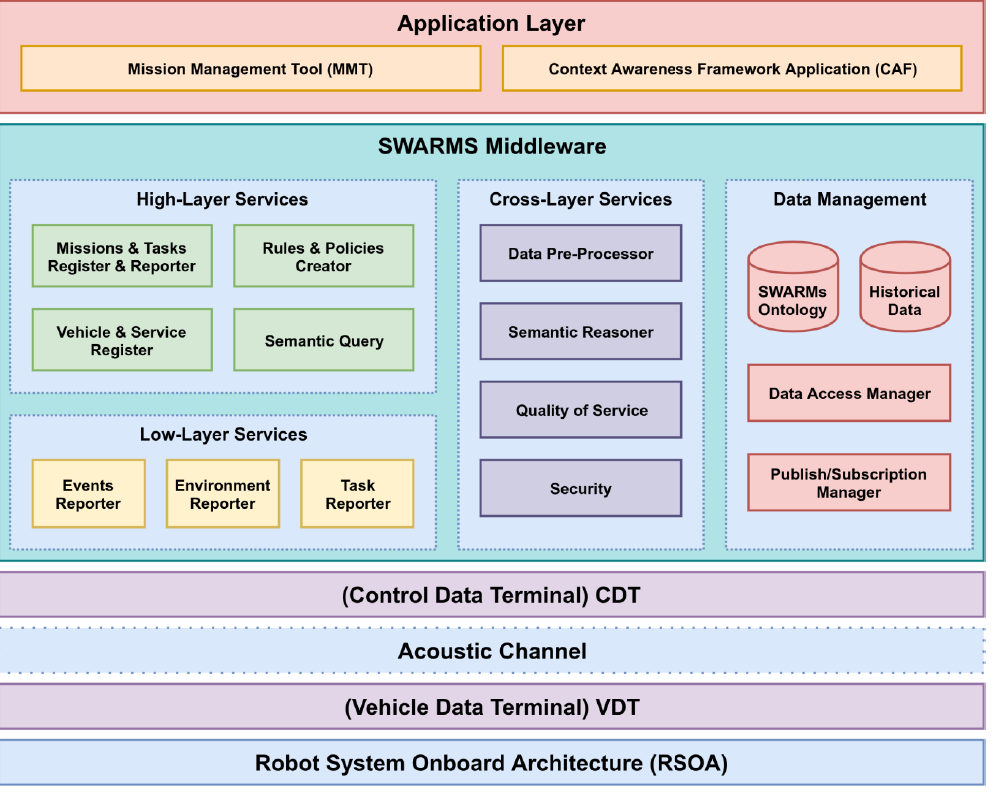
Figure 1. SWARMs architecture overview.